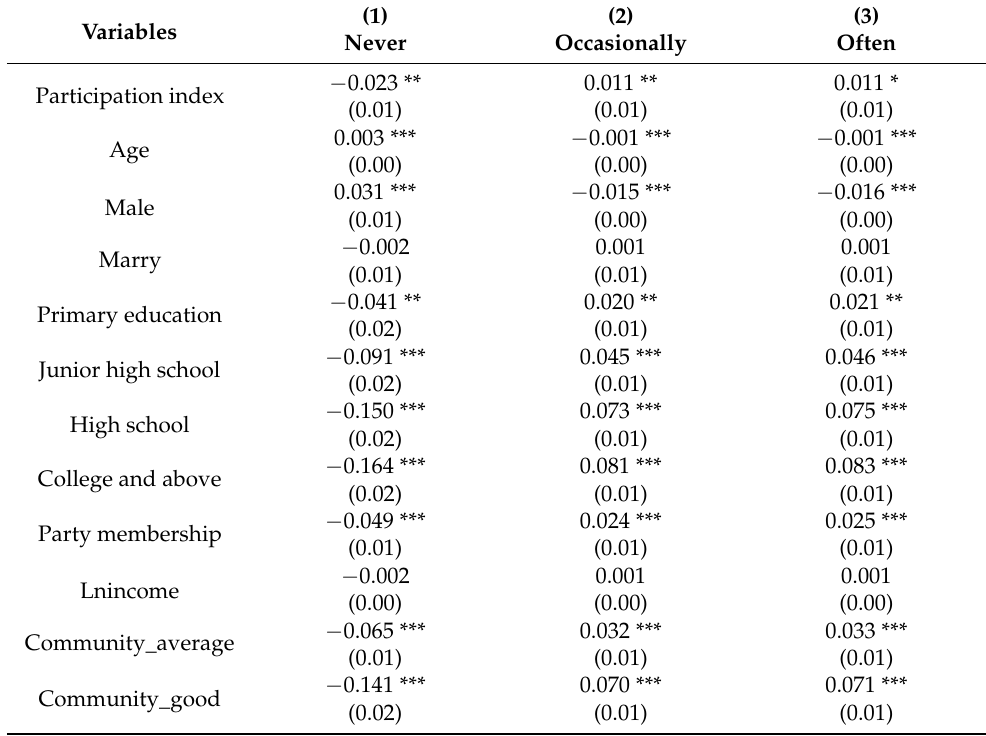
Table A9. Marginal effects of social participation on waste-separation